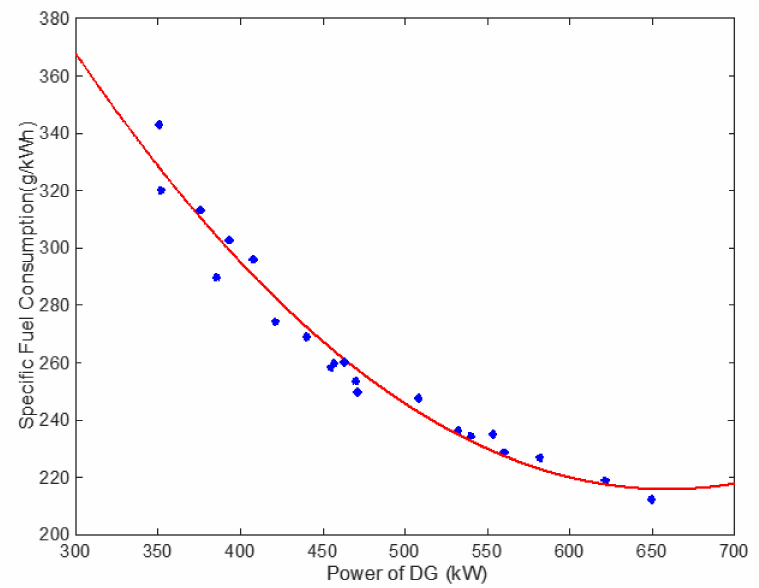
Figure 3. The curve of the specific fuel consumption as a function of an electric